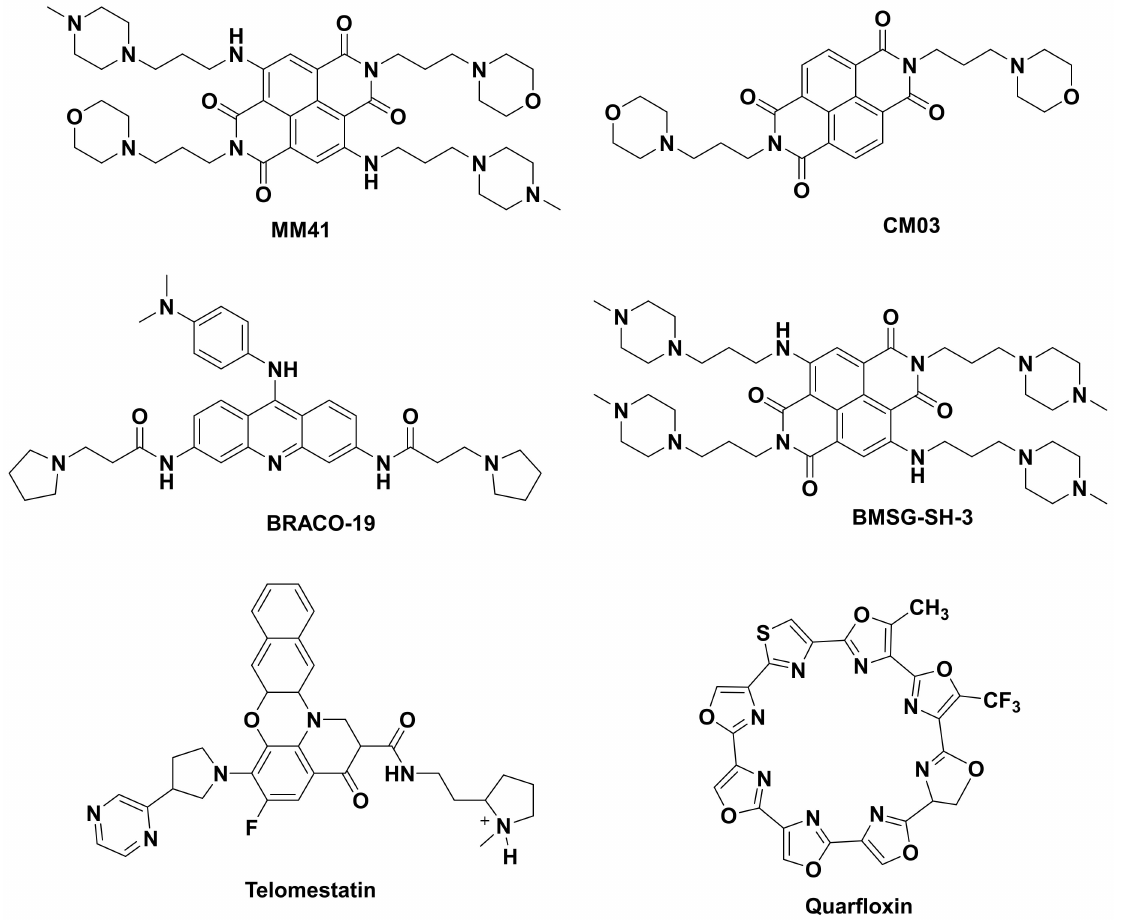
Figure 1. Structures of G4-stabilizing